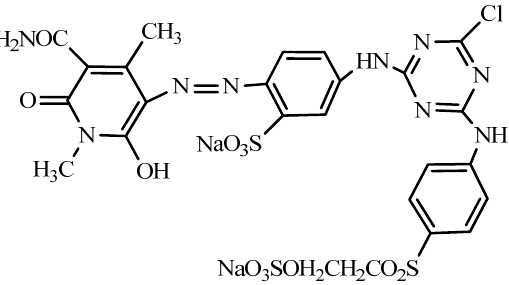
Figure 1. Chemical structure of Reactive Yellow 160A. Table 1. Reactive Yellow 160A specifications.